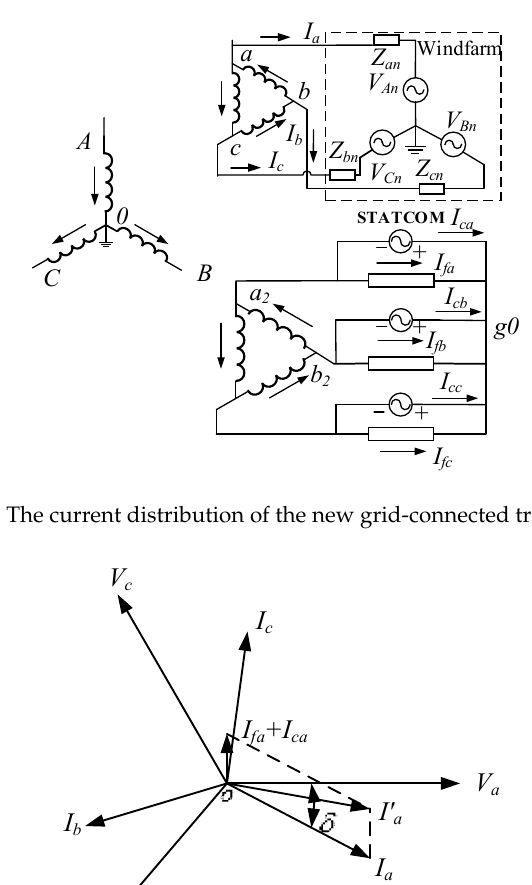
Figure 8. The current distribution of the new grid ‐ connected transformer.